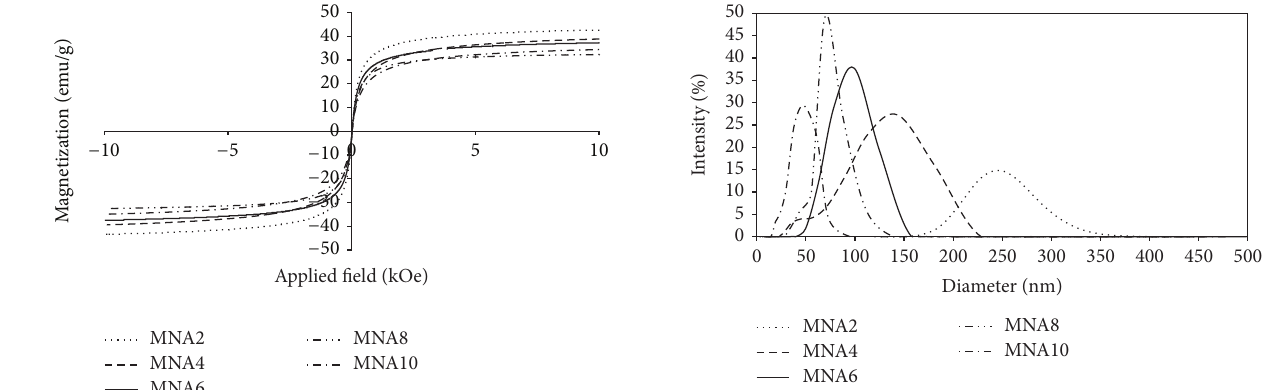
Figure 4: Magnetization curves of maghemite nanoparticles for all samples.